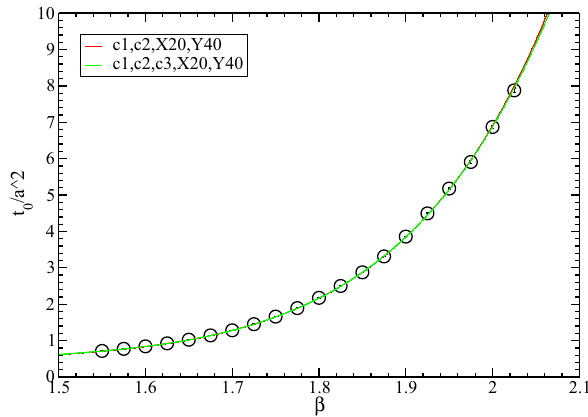
Fig. 4 Interpolation of t 0 versus β using “Fit9” and “Fit10” of Table 5